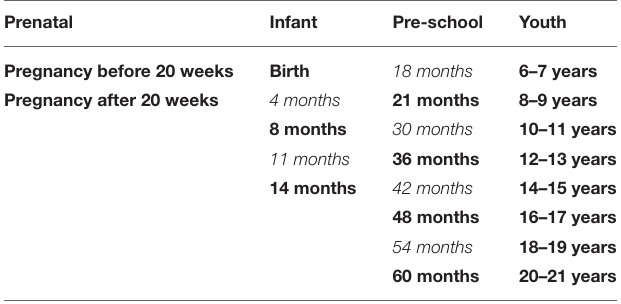
TABLE 2 | Proposed visit